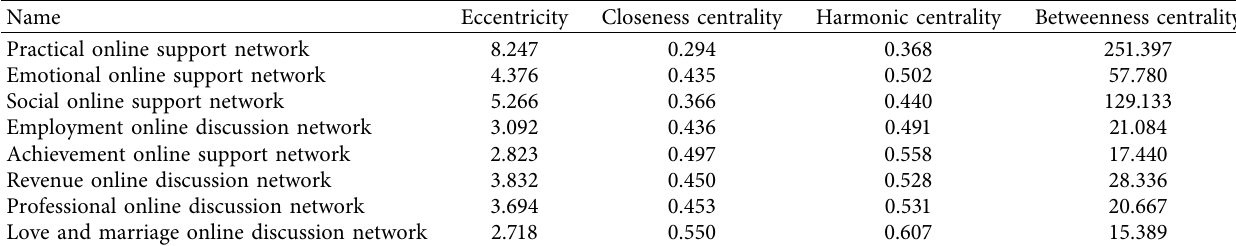
Table 4: Central characteristics of the whole online social network structure of